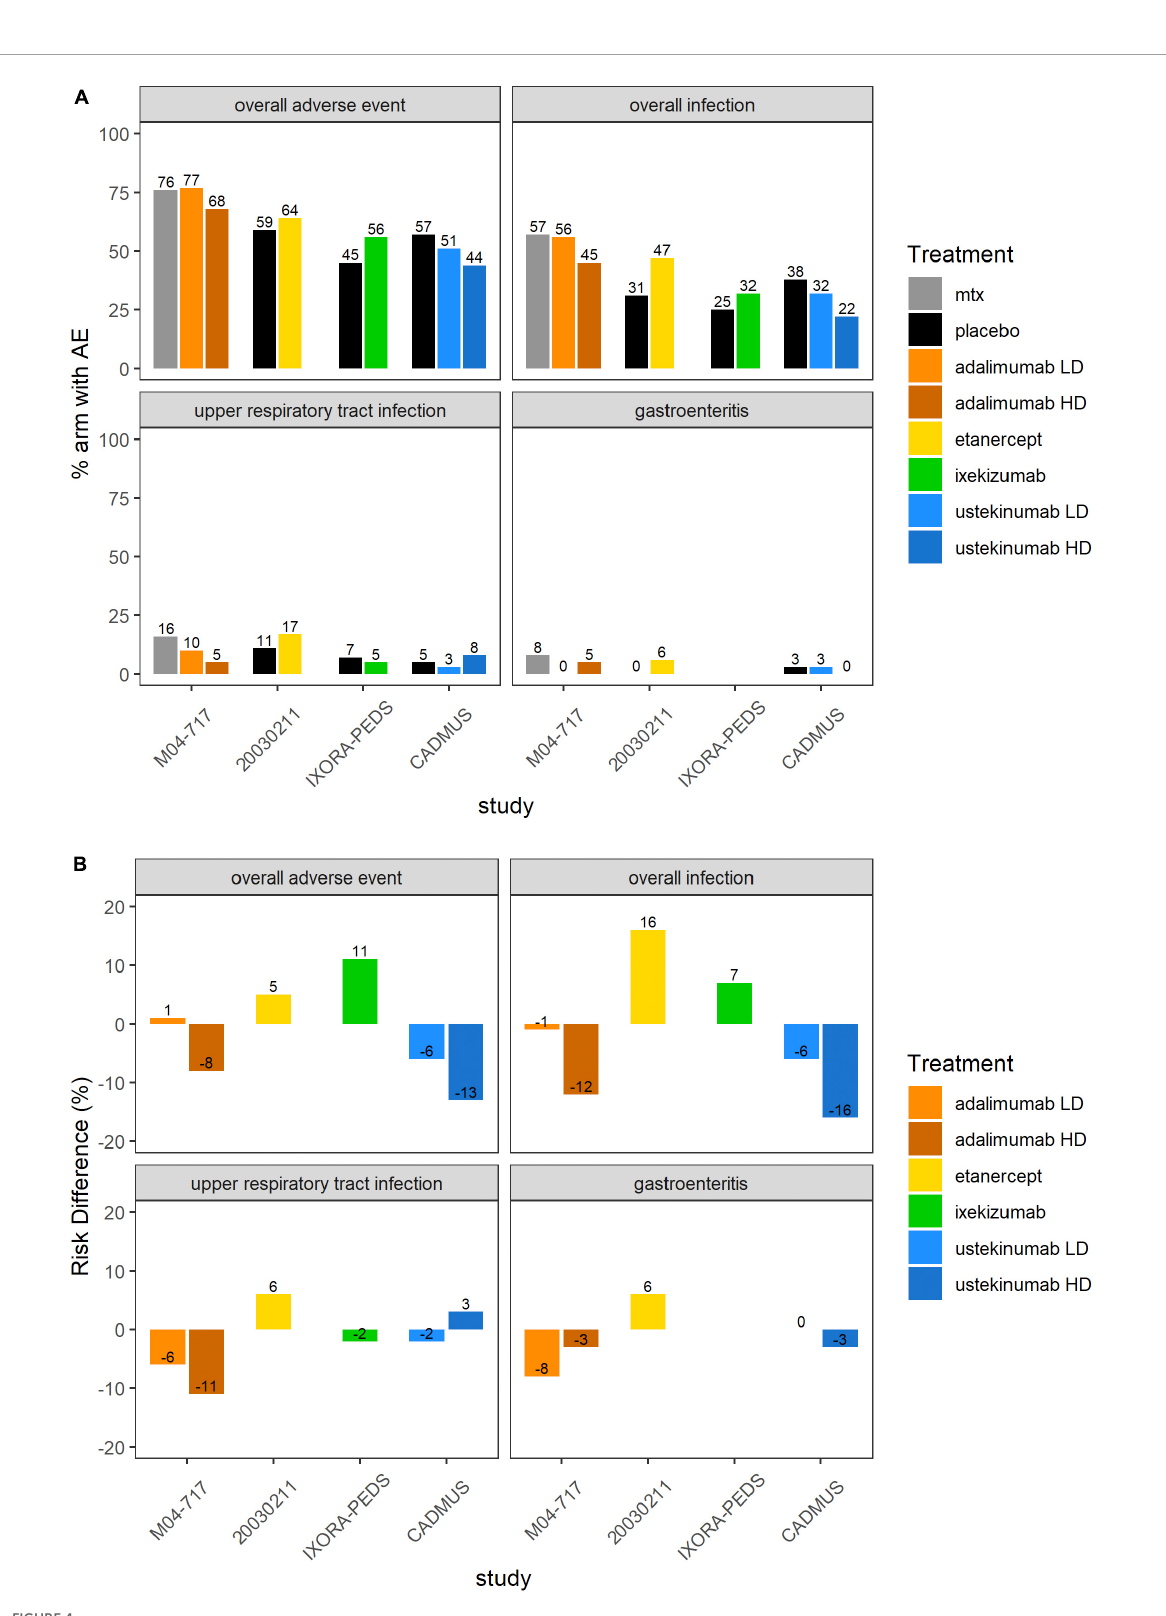
FIGURE4 Overall AEs, overall infections, UTRIs or gastroenteritis in the 5 included pediatric psoriasis RCTs. (A) Proportion (%) of patients with AEs in each study arm. Higher proportion of AEs in the control arm favors experimental treatment. (B) RD (%) of patients with AEs in each treatment arm compared to placebo or SOC. Treatment effect < 0 favors experimental treatment over control arm. AE, adverse event; MTX, methotrexate; RCT, randomized controlled trial; RD, risk